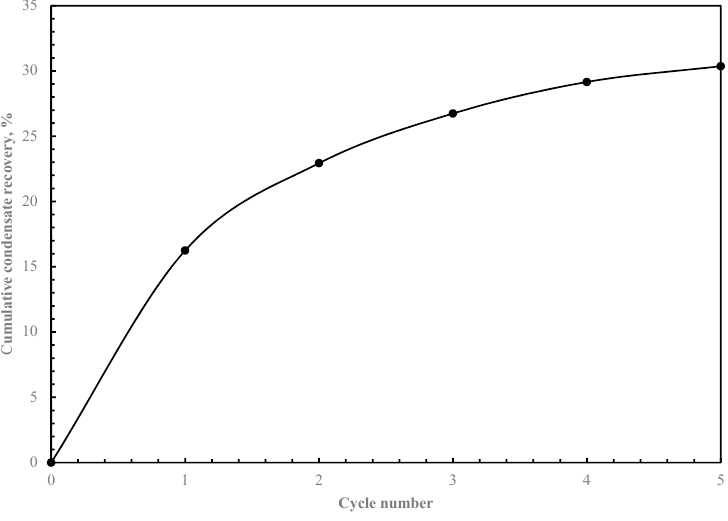
Energies 2018 , 11 , x FOR PEER REVIEW Figure 9. Cumulative condensate recovery. Figure 9. Cumulative condensate recovery. Figure 9. Cumulative condensate recovery.